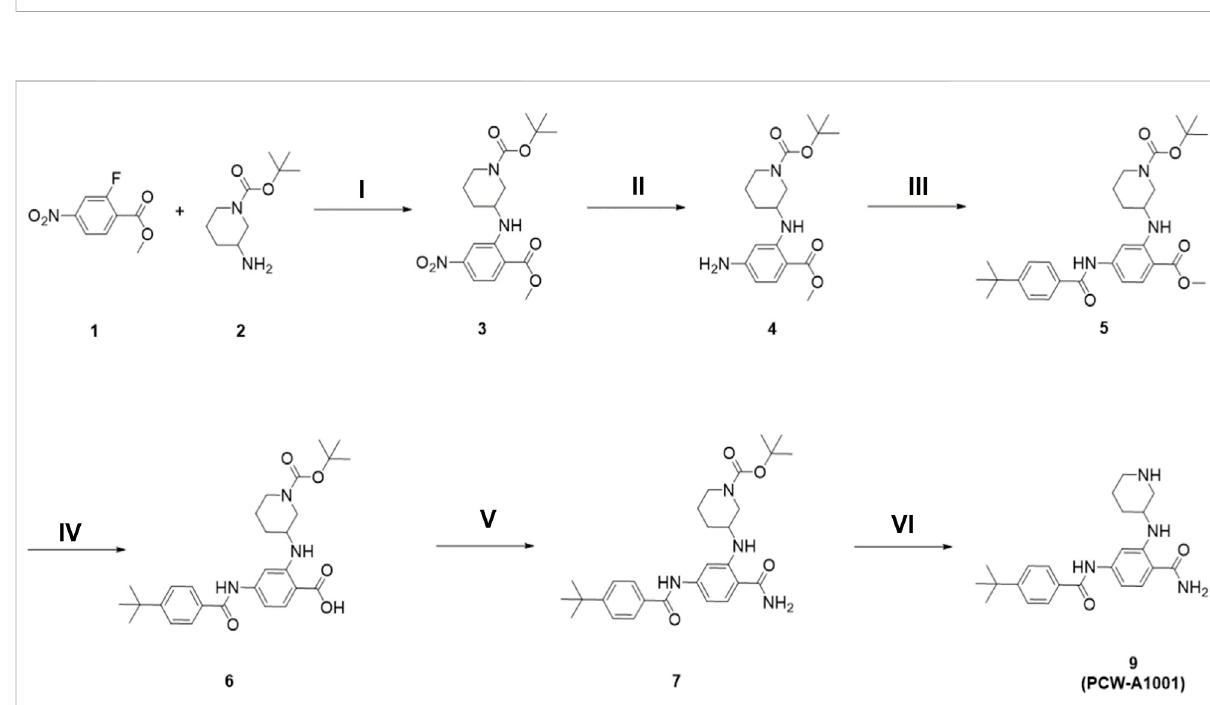
FIGURE 3 OverallpipelineofAIbaseddrugdiscoveryapproachtoidentifyPCW-A1001 fromPCW-1001.Step-1:ThetargetproteinforthePCW-1001was identi fi ed as FLT3 from the network analysis. Step-2: AI-assisted drug design using the RNN-LSTM method. Step-3: Generated compounds were evaluated using various lead-like identi fi cation fi lters. Step-4: Binding mode analysis (Docking, Molecular dynamics, QM/MM, Free energy calculation) of the fi ltered molecules. Step-5: Synthesis and characterization. Step-6: In vitro Assay for the enzymatic activity and cell viability.